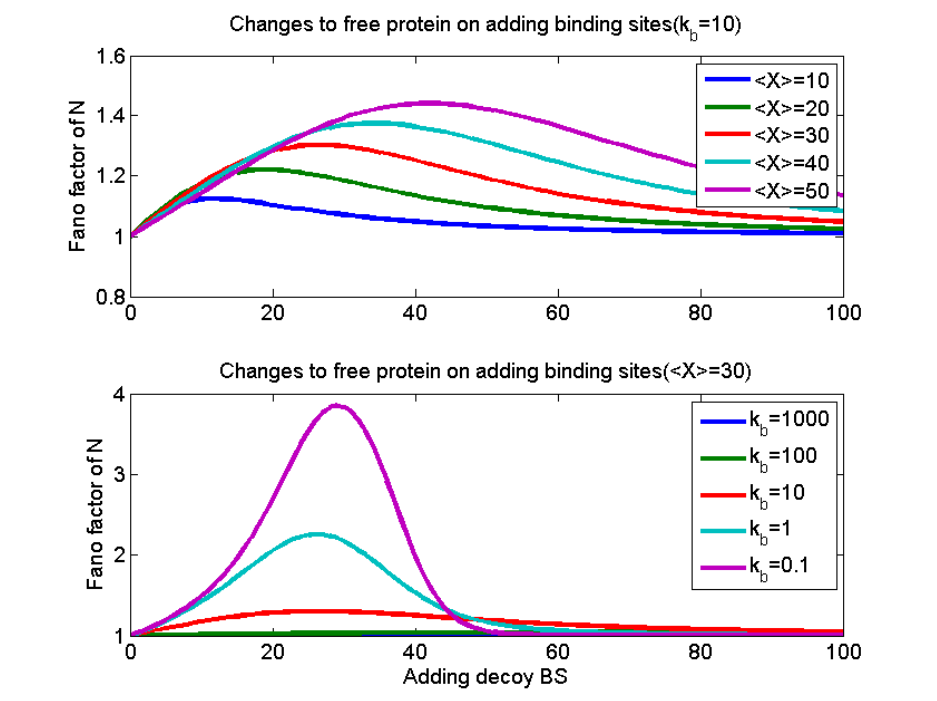
Fig. 4: Fano factor of free protein probability distribution